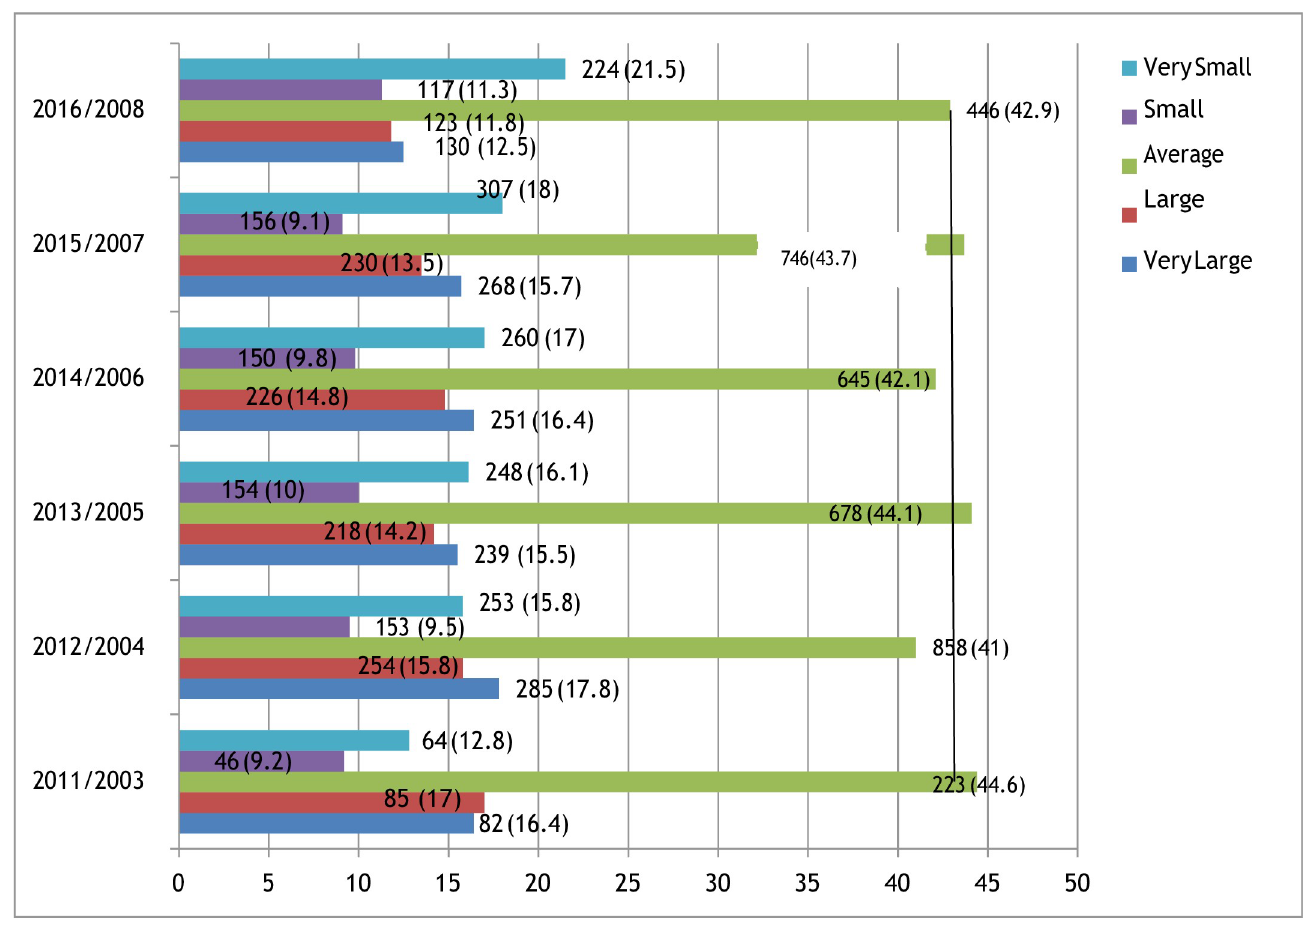
Fig 1. The trends of proximate low birth weight from 2011 to 2016 in Ethiopia.